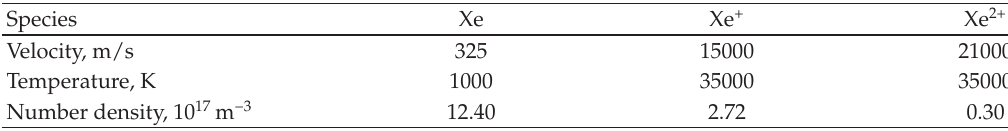
Table 1: Exit parameters of plasma